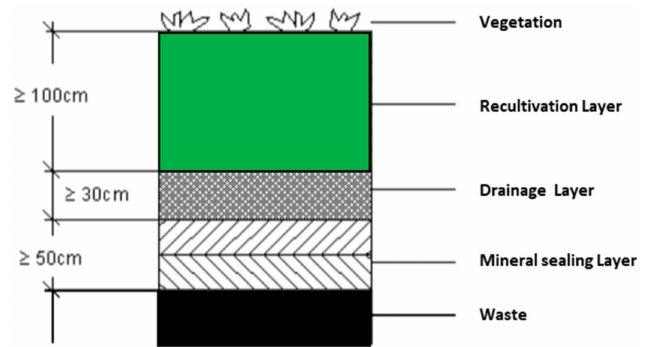
Figure 1. Different layers involved in landfill capping—Landfill Class I Germany (Adapted source: